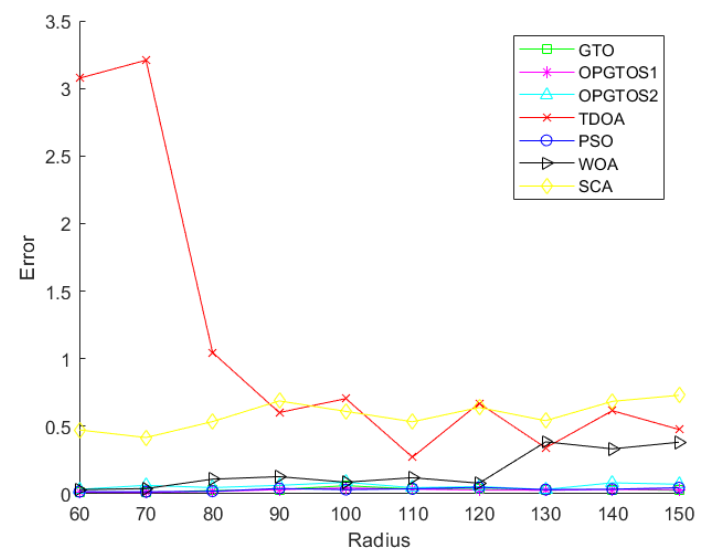
Figure 11. The localization error of TDOA and the optimization